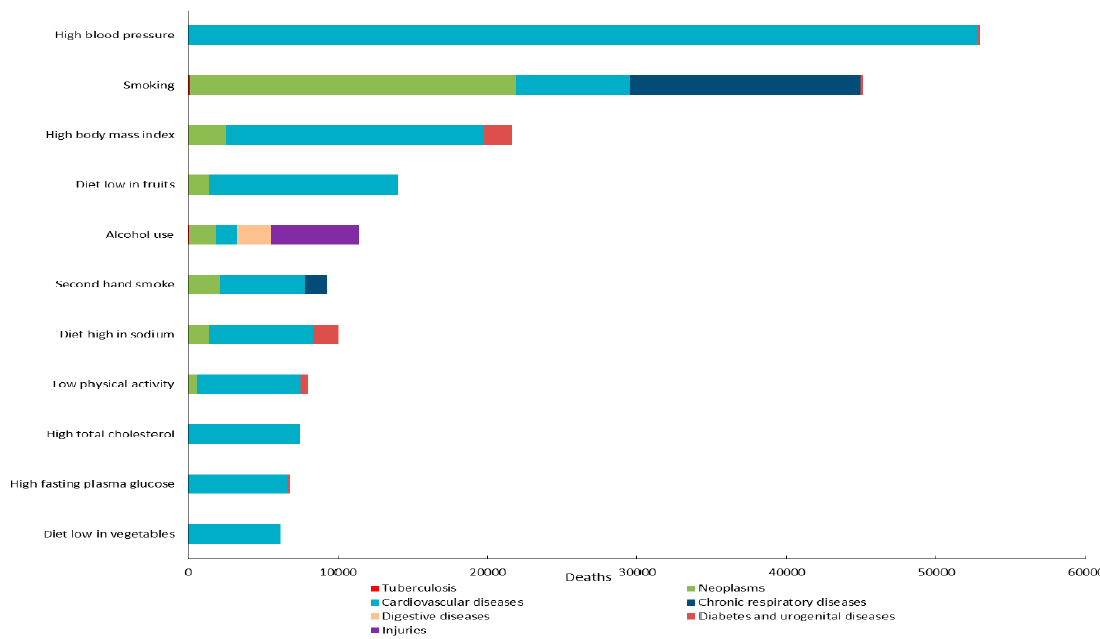
Figure 1. Main causes of deaths attributed to each risk factor for both sexes in Hubei Province in 2013. Table 3 depicts the DALYs caused by each risk factor. The DALY rate attributable to the 11